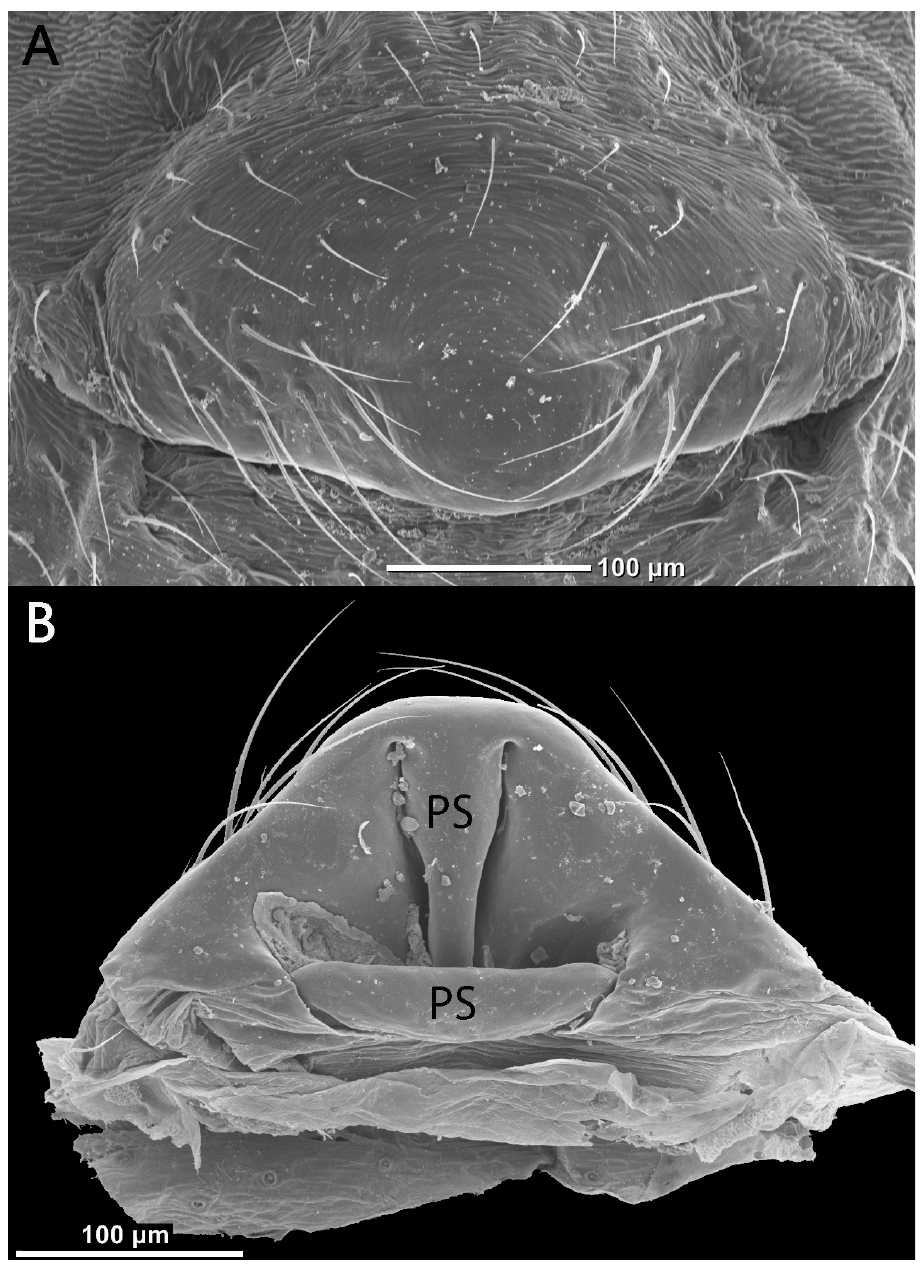
Figure 4. SEM micrographs of the epigynum of Islandiana lewisi sp. n. A Epigynum, ventral view B Epigynum, flipped – dorsal view. PS = posterior